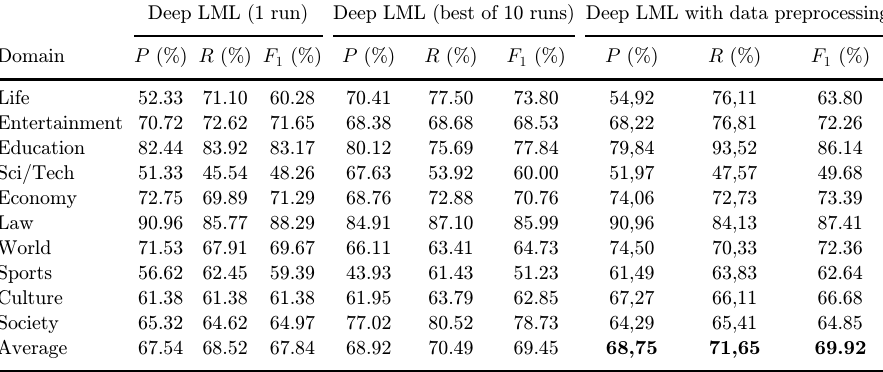
Table 8. Cross-domain with unlabeled data preprocessing results.